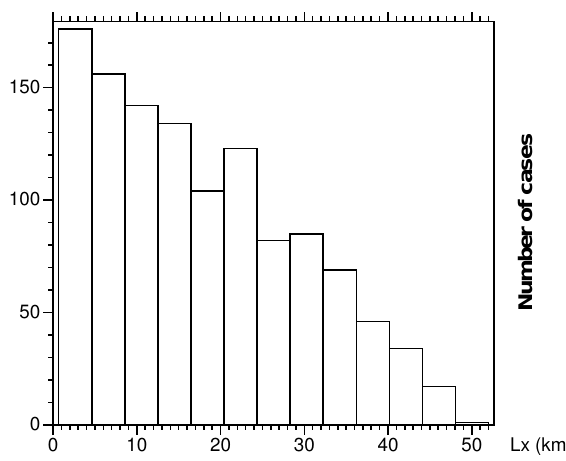
Fig. 7. Scatter plot of particle’s angular momentum L z and mini- mum radial distance r min in the test particle simulation.